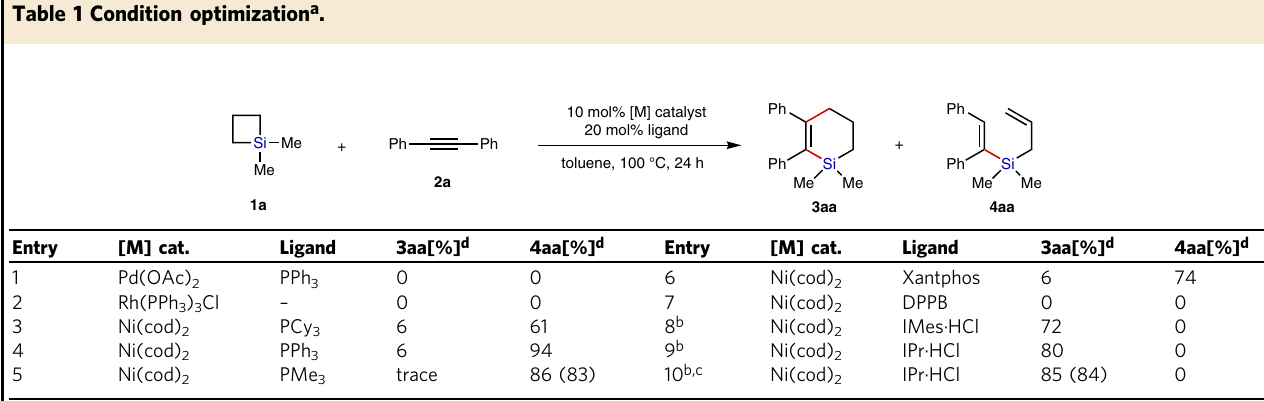
Table 1 Condition optimization a